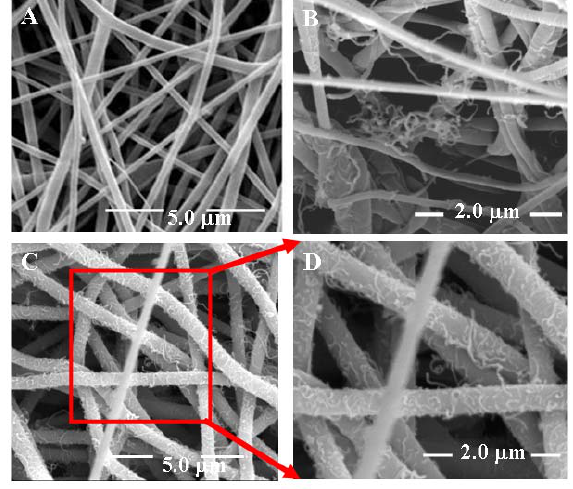
Figure 5. SEM images of (A) neat Nylon-6 nanofibers; (B) cross-sectional view of sa MWCNTs/Nylon-6 nanofiber composite showing that the MWCNTs reach even inside the electrospun nanofiber mat; (C) sa MWCNTs on the Nylon-6 nanofibers; (D) enlarged view of sa MWCNTs on Nylon-6 nanofibers.